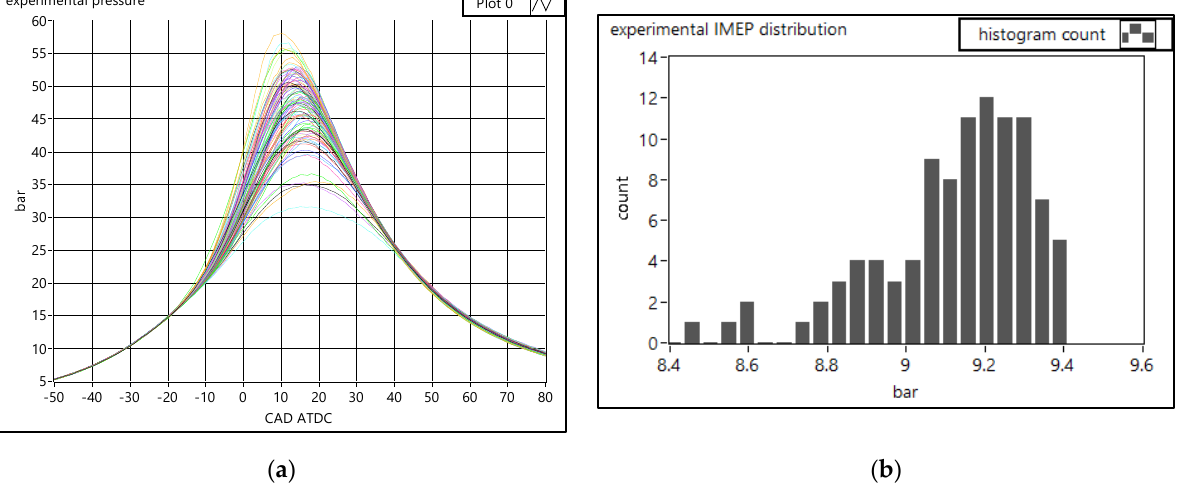
Figure 10. MAP = 1 bar, engine speed n = 3500 rpm, fuel 100% NG. ( a ) 100 consecutive pressure cycles; ( b ) histogram of IMEP distribution (mean value = 9.11 bar, SD = 0.214 bar).